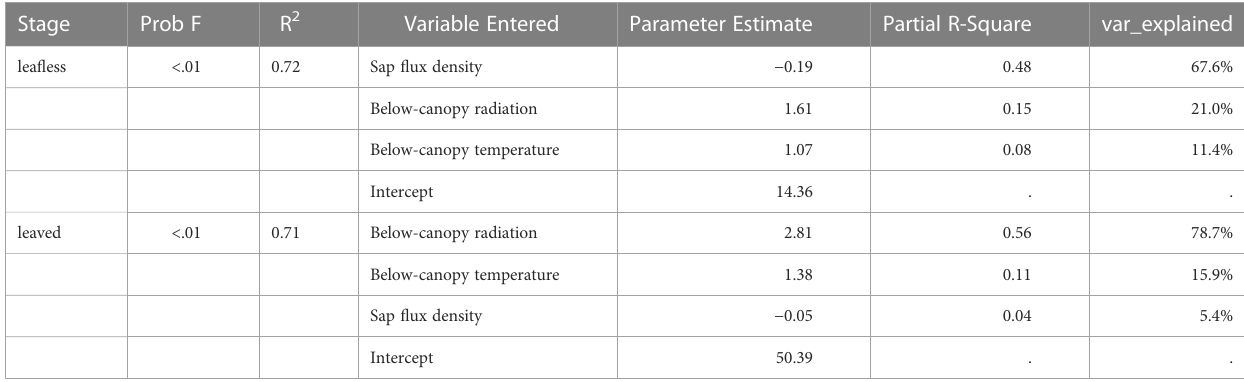
TABLE 2 Stepwise linear multiple regression model predicting E s with environmental factors.